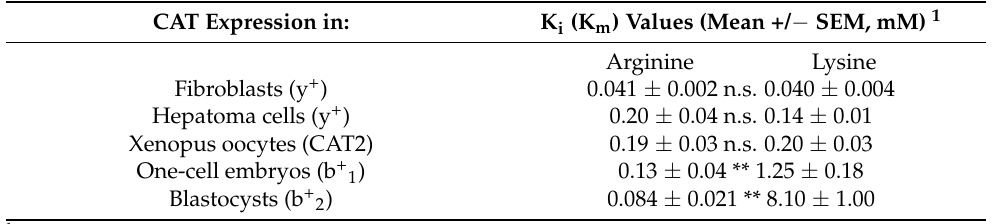
Table 2. The K i /K m values for Arginine and Lysine transport by cationic amino acid transporters (CATs) are nearly identical in adult tissues or during heterologous expression in Xenopus oocytes, but the values are one or two orders of magnitude different for CATs expressed in preimplantation mouse embryos (**, p <